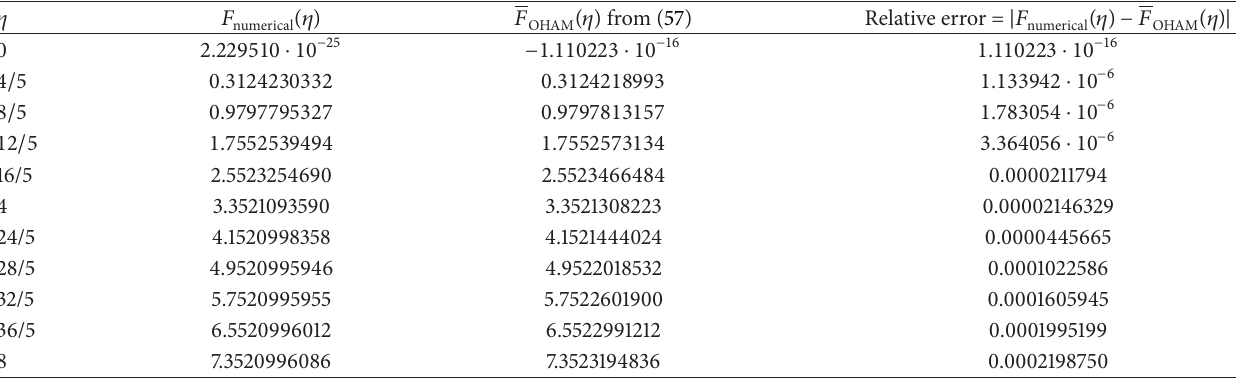
Table 10: Comparison between OHAM results given by (57) and numerical solutions for 𝛽 = 1 .